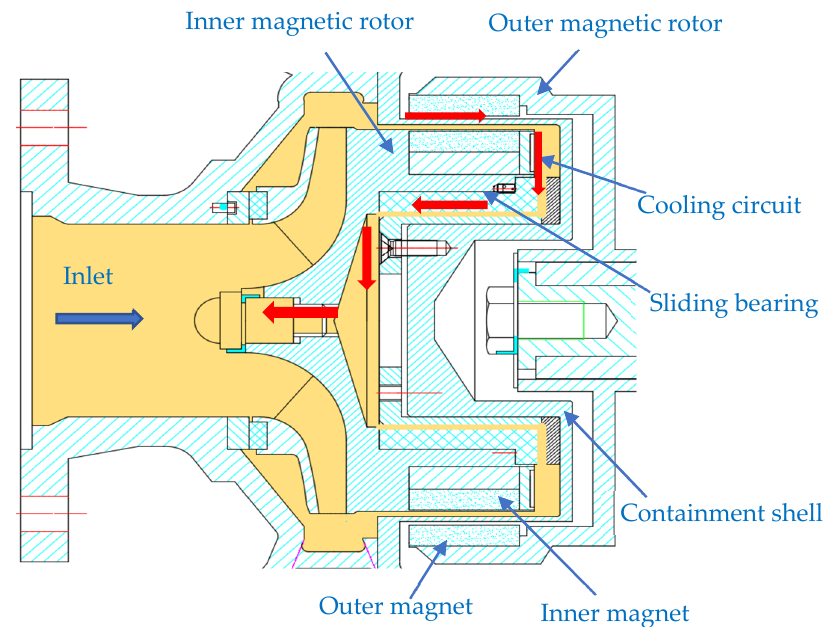
Figure 2. Schematic diagram of the cooling circuit.